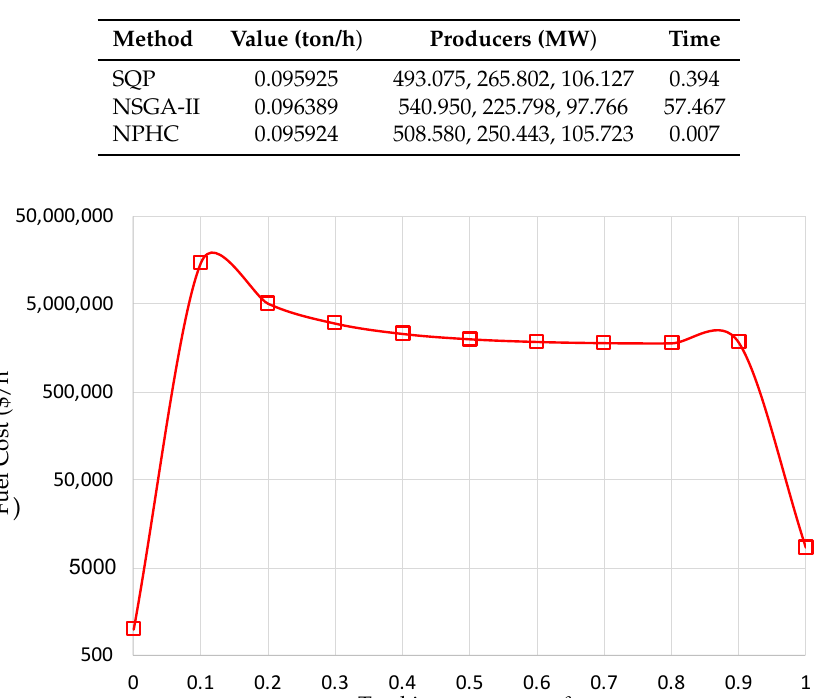
Figure 2. Trajectory of the minimization of the fuel cost objective function with the NPHC algorithm.